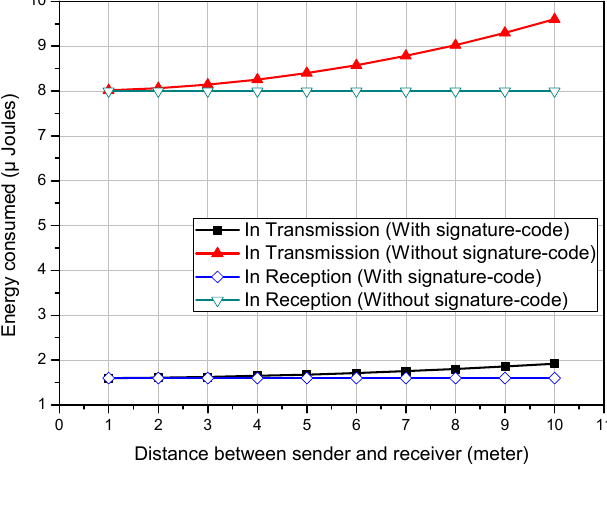
Figure 9. Comparison of energy consumption with and without signature-code.